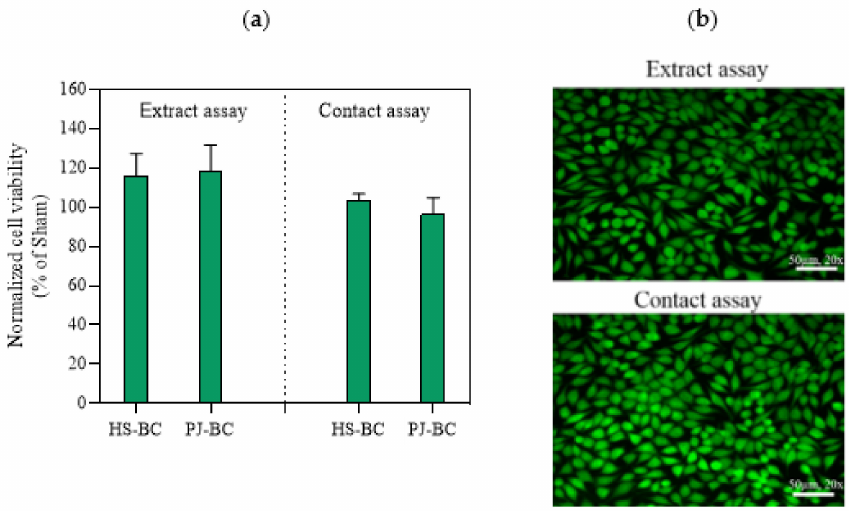
Figure 8. ( a ) L929 fibroblast viability data, as a percentage of the sham; ( b ) fluorescence live/dead visualization of L929 fibroblasts exposed PJ-BC for 24 h (extract and direct contact) and stained with Syto 9 (green, live) and propidium iodide dyes (red, dead). Data are presented as mean ± standard error of the mean (SEM); HS-BC—BC biosynthesized in HS medium; PJ-BC—BC biosynthesized in PJ